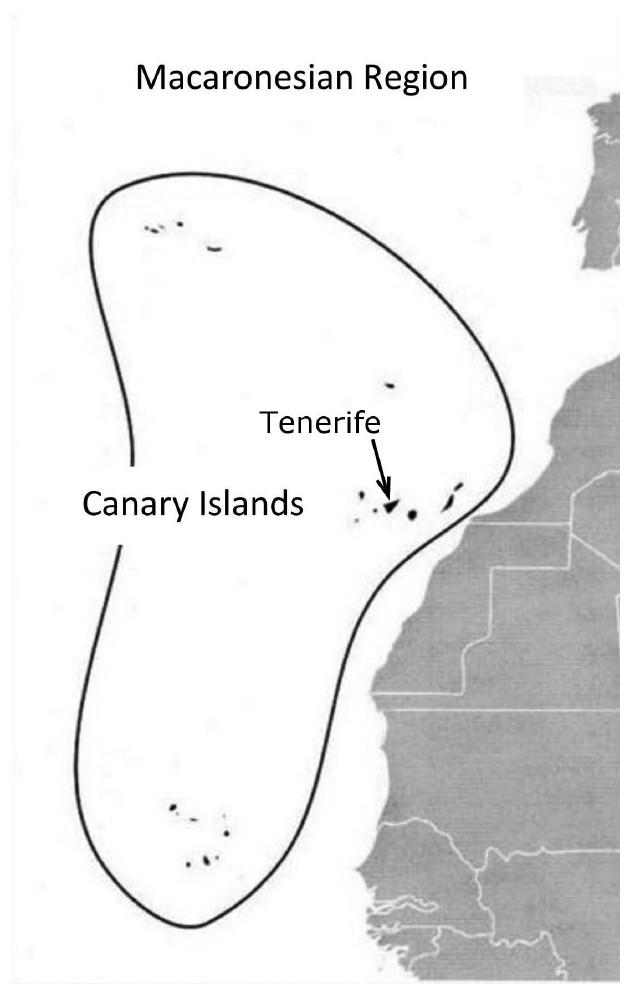
Figure 1 – Position of Tenerife, the Canary Island and the Macaronesian Region in the North Atlantic.